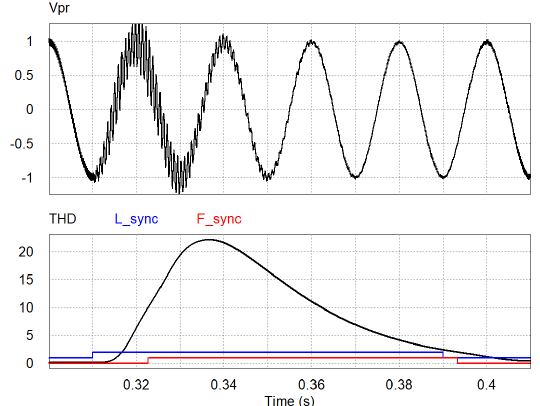
Figure 25. Primary voltage resonance detection and